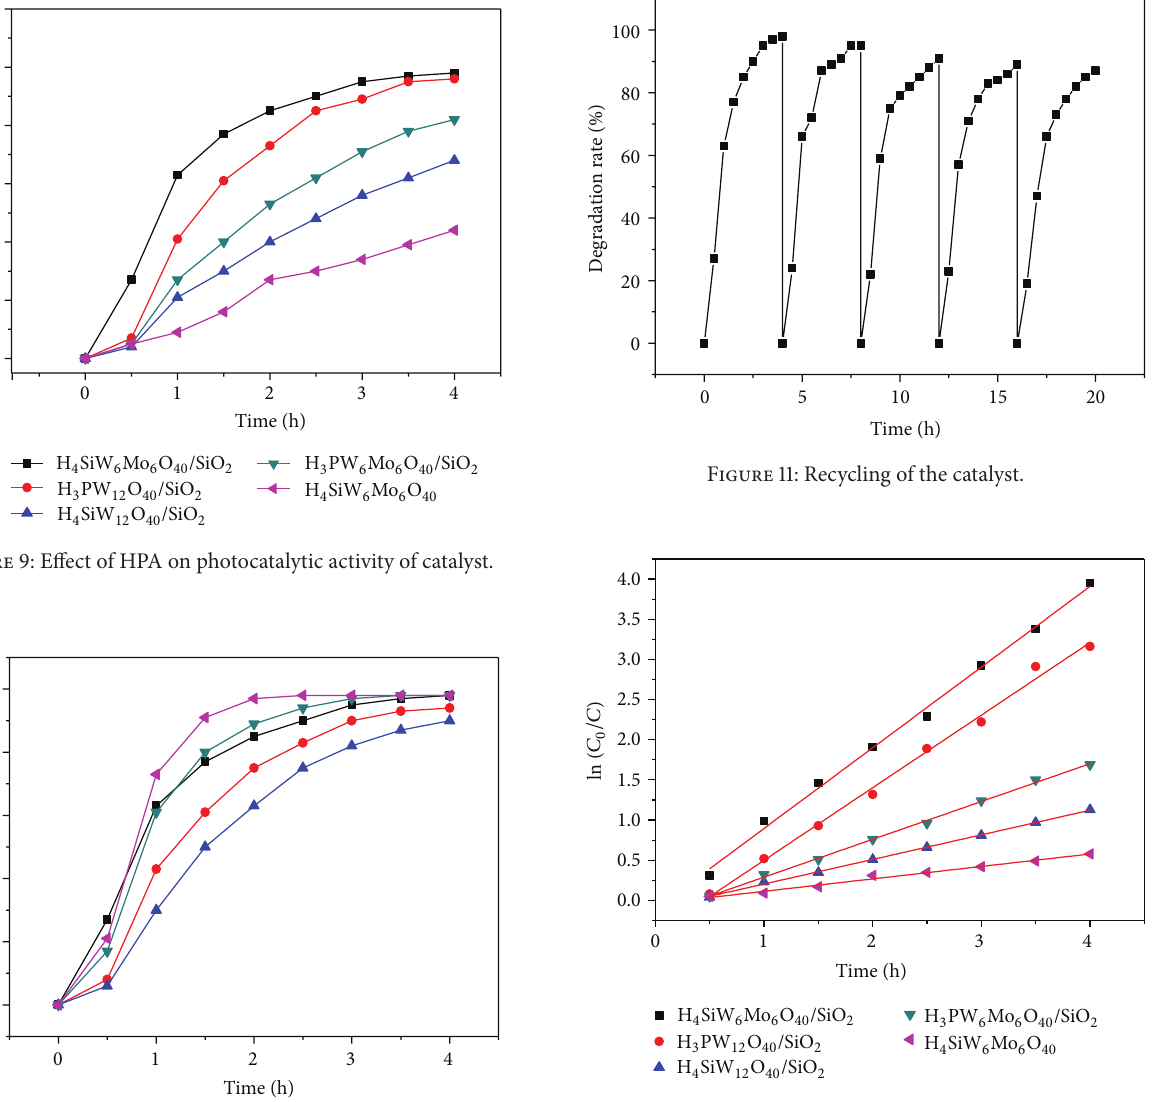
Figure 12: Relation curve of ln (𝐶 0 /𝐶) and time (𝑡)